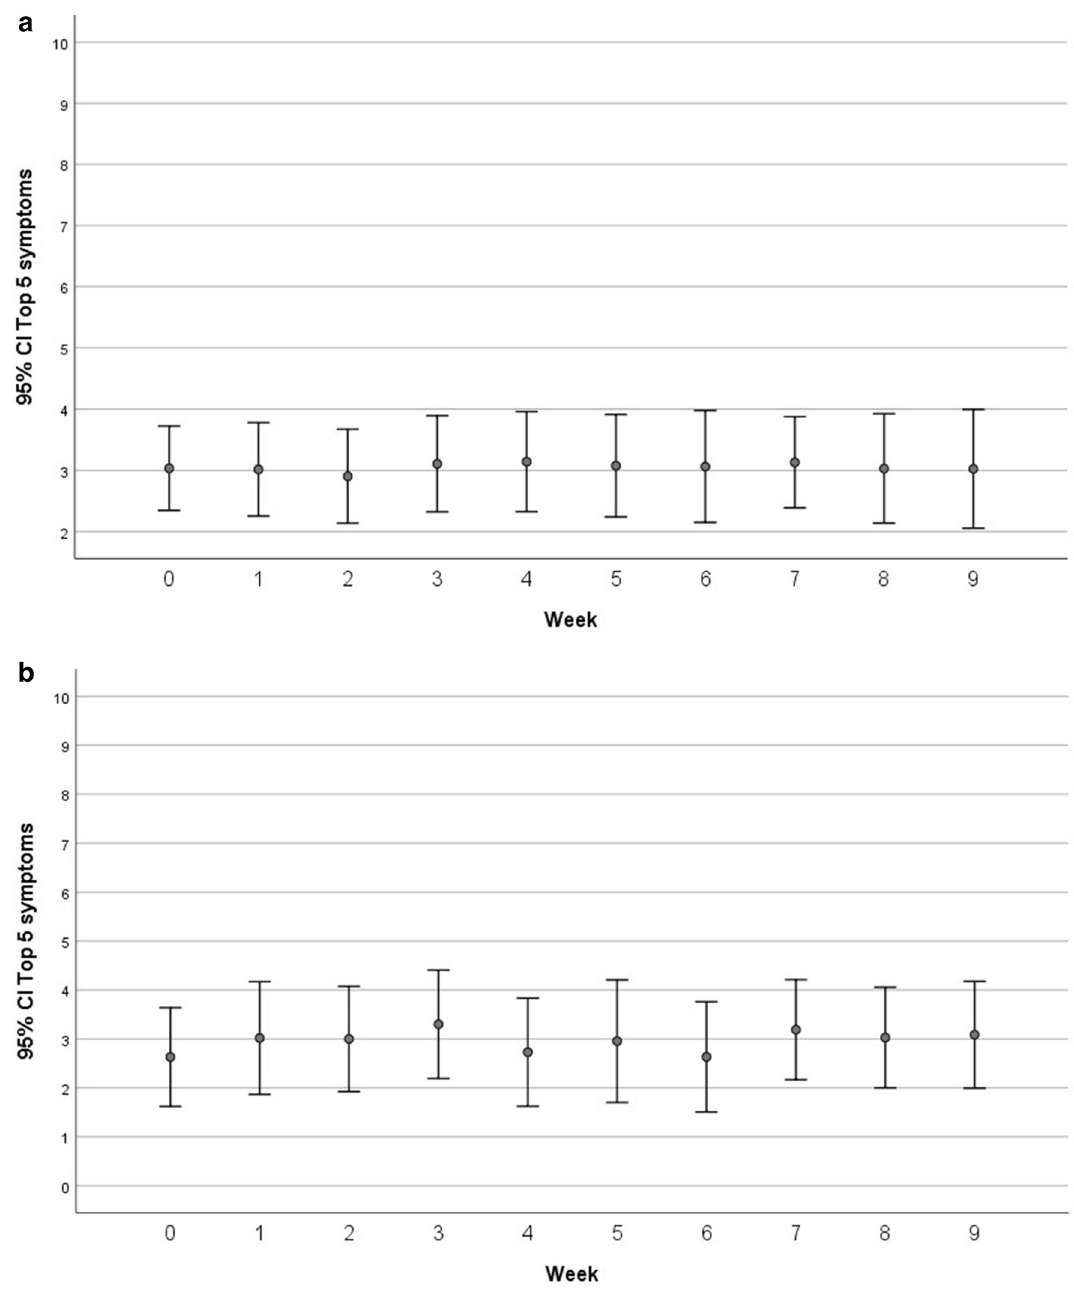
Figure 1. ( a ) Mean values for the composite score of the top five symptoms (pain, fatigue, disturbed sleep, lack of appetite, and drowsiness) over 9 weeks of treatment with pembrolizumab in all patients with rare tumors who started the trial (N = 53). ( b ) Mean values for the composite score of the top five symptoms over 9 weeks of treatment with pembrolizumab in patients with rare tumors who completed 9 weeks of treatment with pembrolizumab (N =